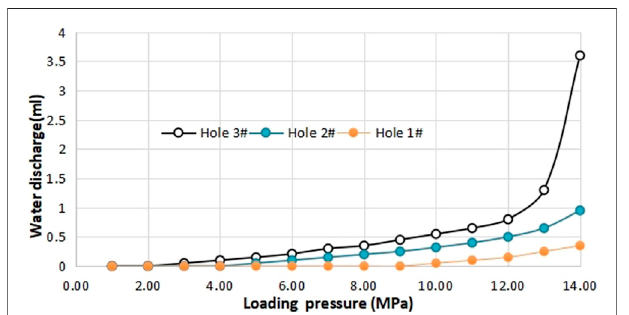
FIGURE 7 | Diagram of controlled blasting borehole layout. TABLE 2 | Relevant parameters of coal seam blasting